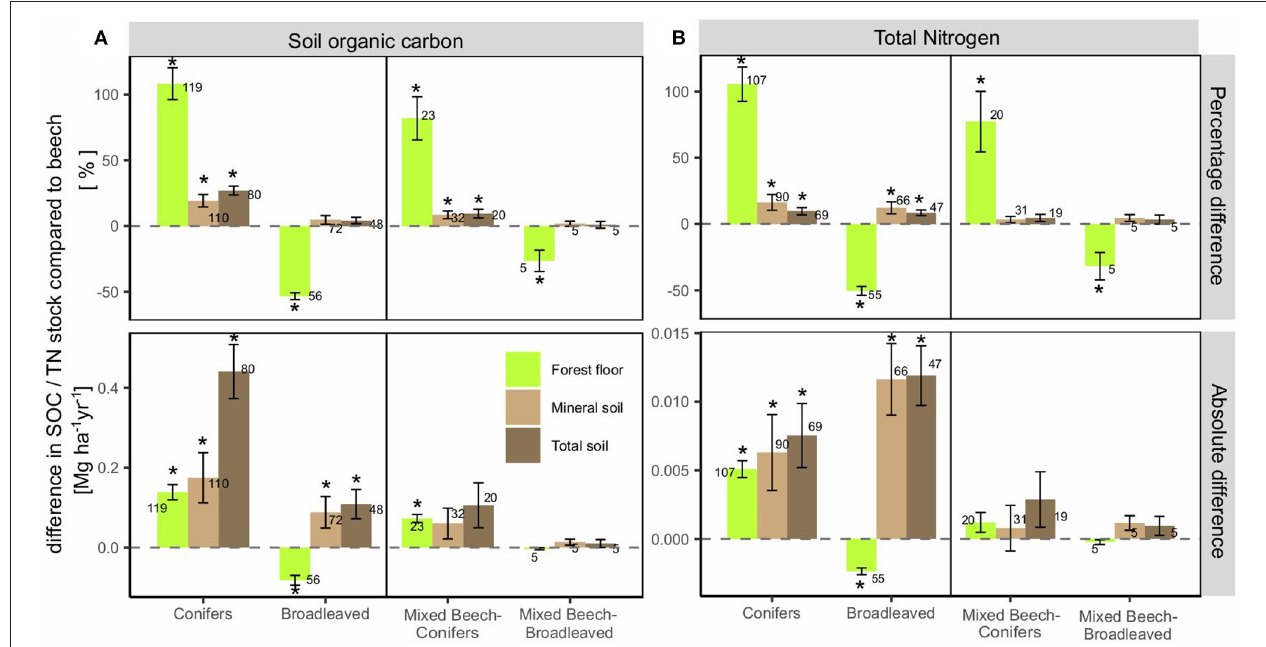
FIGURE 3 | Average percentage and absolute annual differences of (A) SOC and (B) TN stocks summarized for monocultures (conifers, broadleaved) and mixtures with beech (mixed beech-conifers/mixed beech- broadleaved) compared to beech monocultures. Average mixing ratio: 50%/50%. Numbers next to the bars are the number of observations. Error bars show the standard error. Asterisks indicated significant differences compared to beech monocultures. Note that in some cases the difference for the total soil is not the sum of those for the forest floor and mineral soil, since not all studies included observations for both